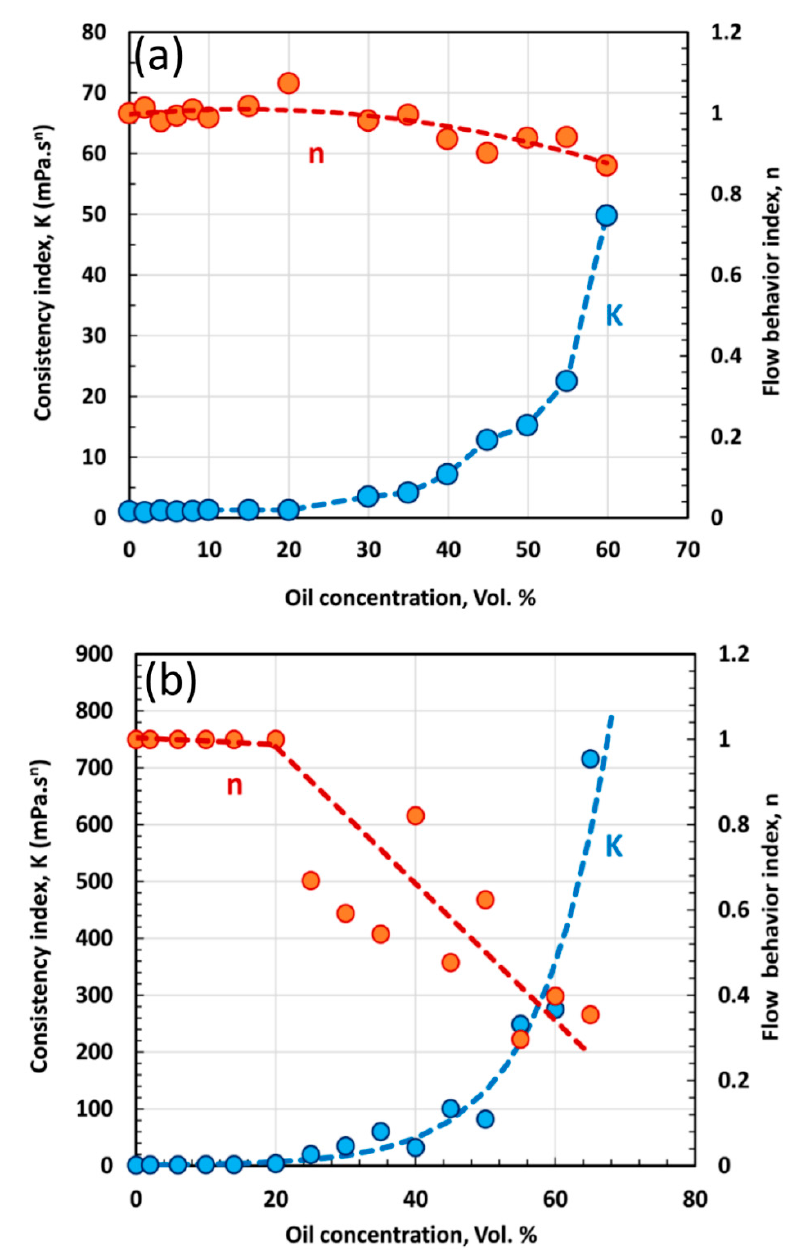
Figure 7. Variations of consistency index K and flow behavior index n for ( a ) surfactant-stabilized and ( b ) nanoparticle-stabilized O / W emulsions with the increase in the dispersed-phase (oil)